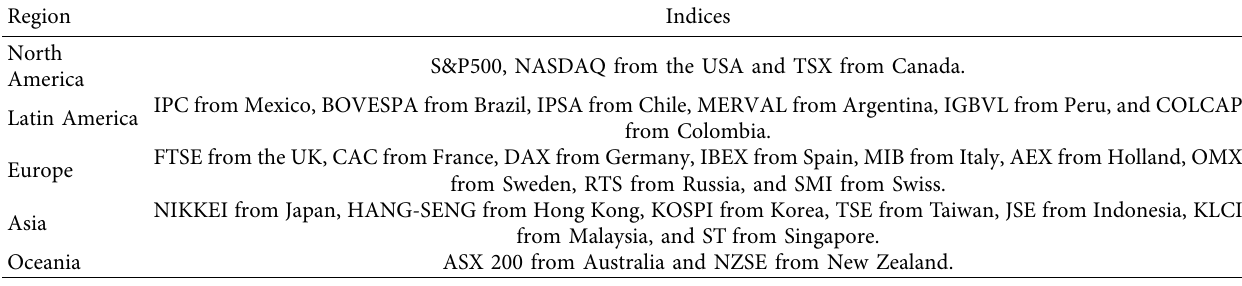
Table 1: Indices by region.